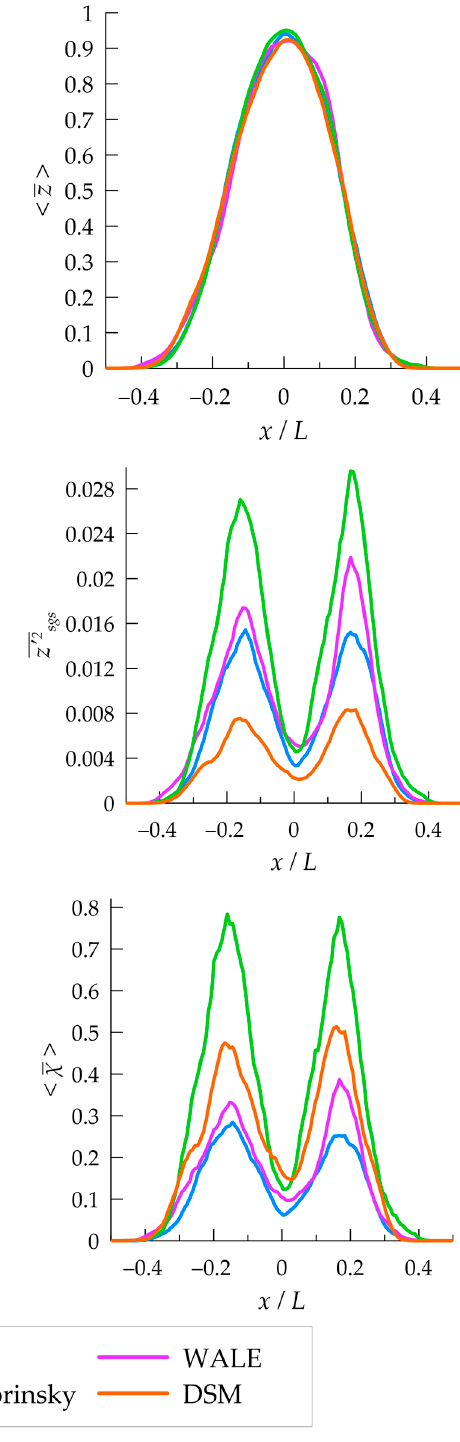
0 . Designations as in Figure